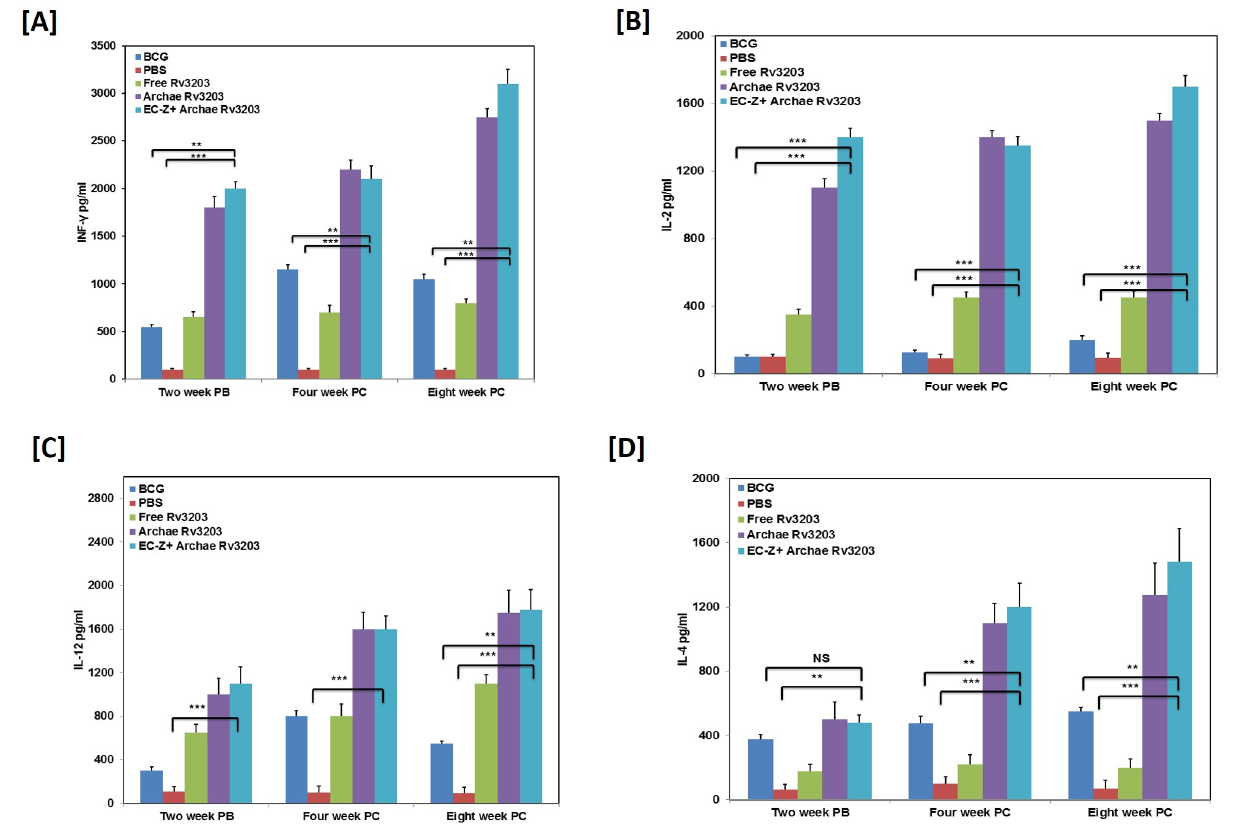
Fig 2. Archaeosome encapsulated Rv3203 has bias to induce type I cytokine expression in the immunized mice. The level of both Type I/Type II cytokines were determined in the splenocyte culture supernatant belonging to various immunized groups at various time points; (A) IFN- γ , (B) IL-2, (C) IL-12, (D) IL-4. (PB- post booster, PC-post challenge).Confirmation of Th1/Th2 polarization expression upon immunization with archaeosome encapsulated Rv3203 . Data represent mean ± SD from three independent experiments. Statistical significance was determined as described in materials and methods. p (cid:1) 0.05, p < 0.01, p < 0.001 and p > 0.05 represented as ( * ), ( ** ), ( *** ) and (NS)